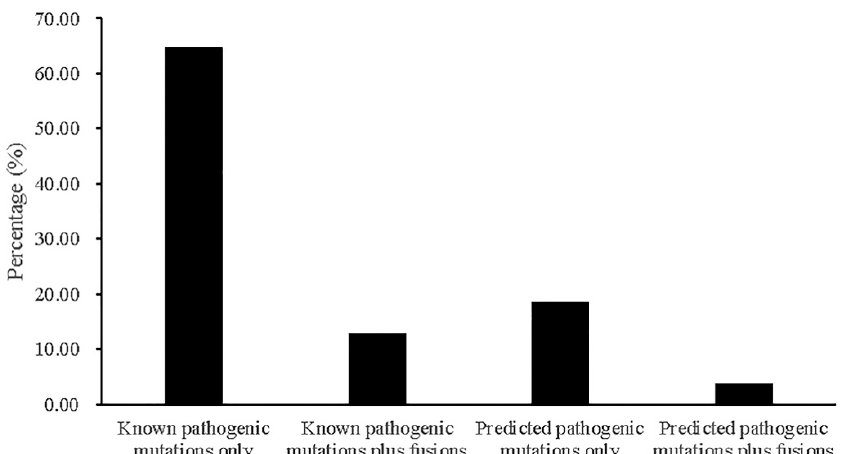
Figure 3. The chart shows the percentages of samples containing known pathogenic mutations only, predicted pathogenic mutations only, known pathogenic mutations plus fusions, or pre- dicted pathogenic mutations plus fusions in 299 known cancer driver genes.